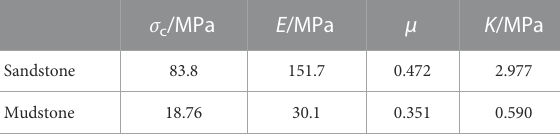
TABLE 2 Main mechanical properties of sandstone and